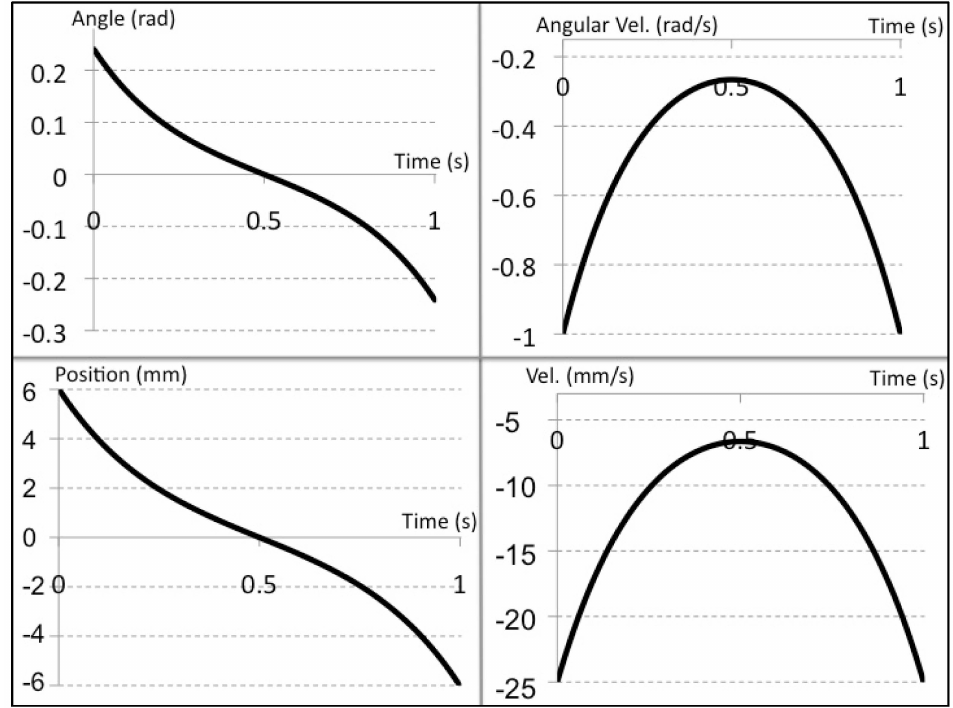
Figure 27. Input data for the Ankle Pitch joint in active mode. ( a ) ankle pitch joint angle; ( b ) ankle pitch joint angular velocity; ( c ) Slider Position; ( d ) slider